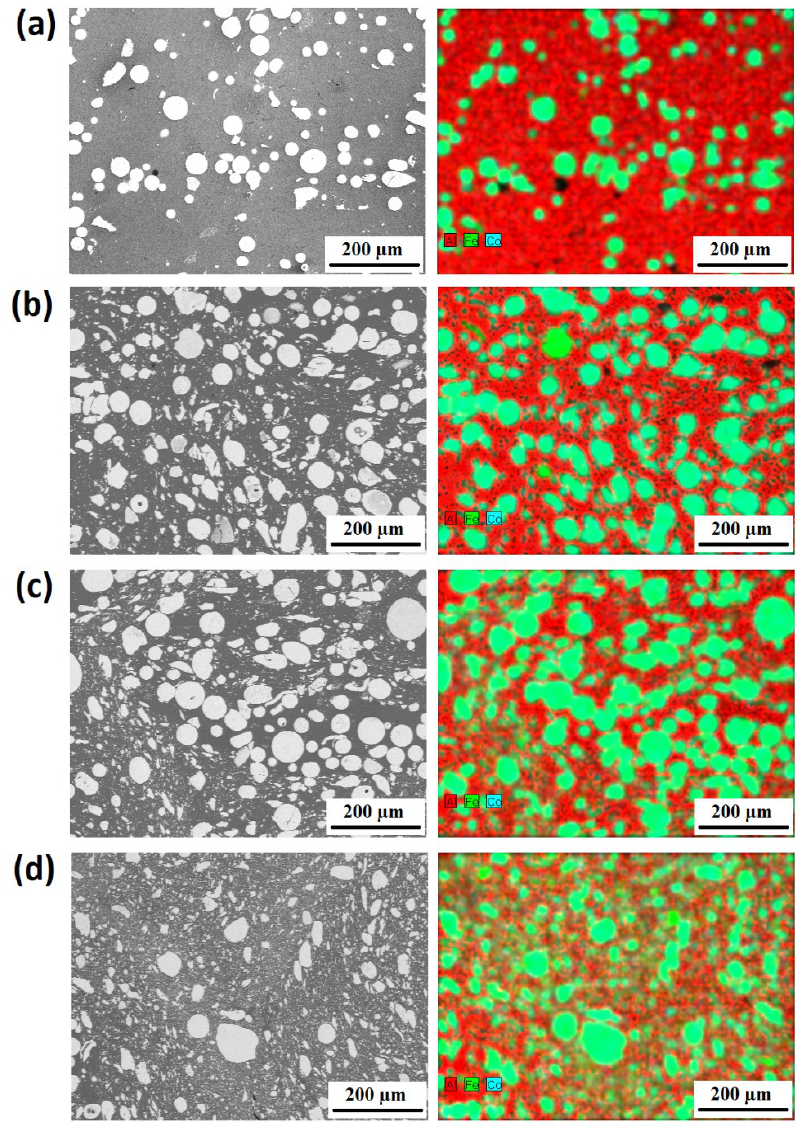
Figure 4. SEM micrographs and EDX maps of the hot pressed composites obtained